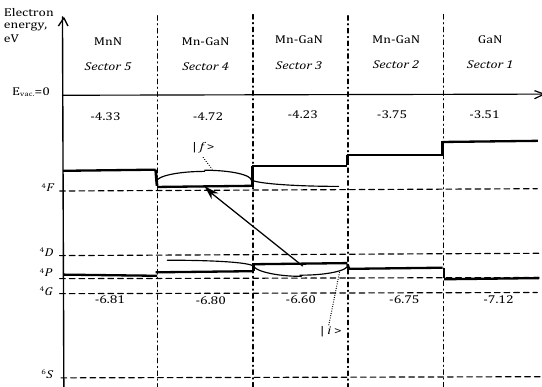
Figure 2. Linear Combination of Atomic Orbitals electron band structure of wurtzite Mn